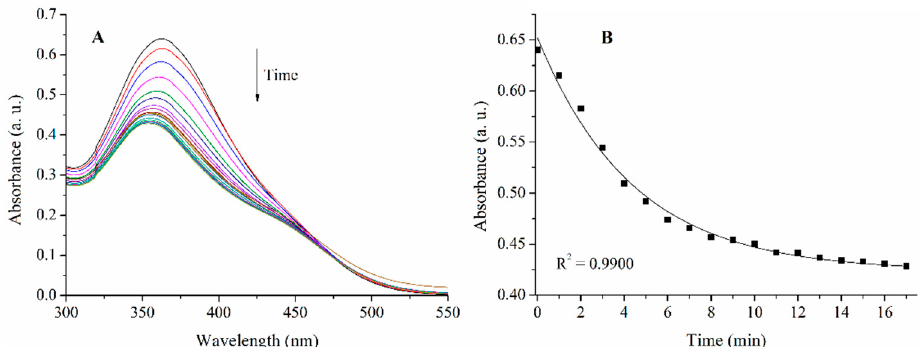
Figure 4. UV-vis spectra of a 50 µM solution of trans -PHX exposed to 366 nm light ( A ) and the intensity of the peak at 360 nm plotted against time ( B ). The first spectrum was recorded before the beginning of the UV-light exposure, then measurements were taken every minute.